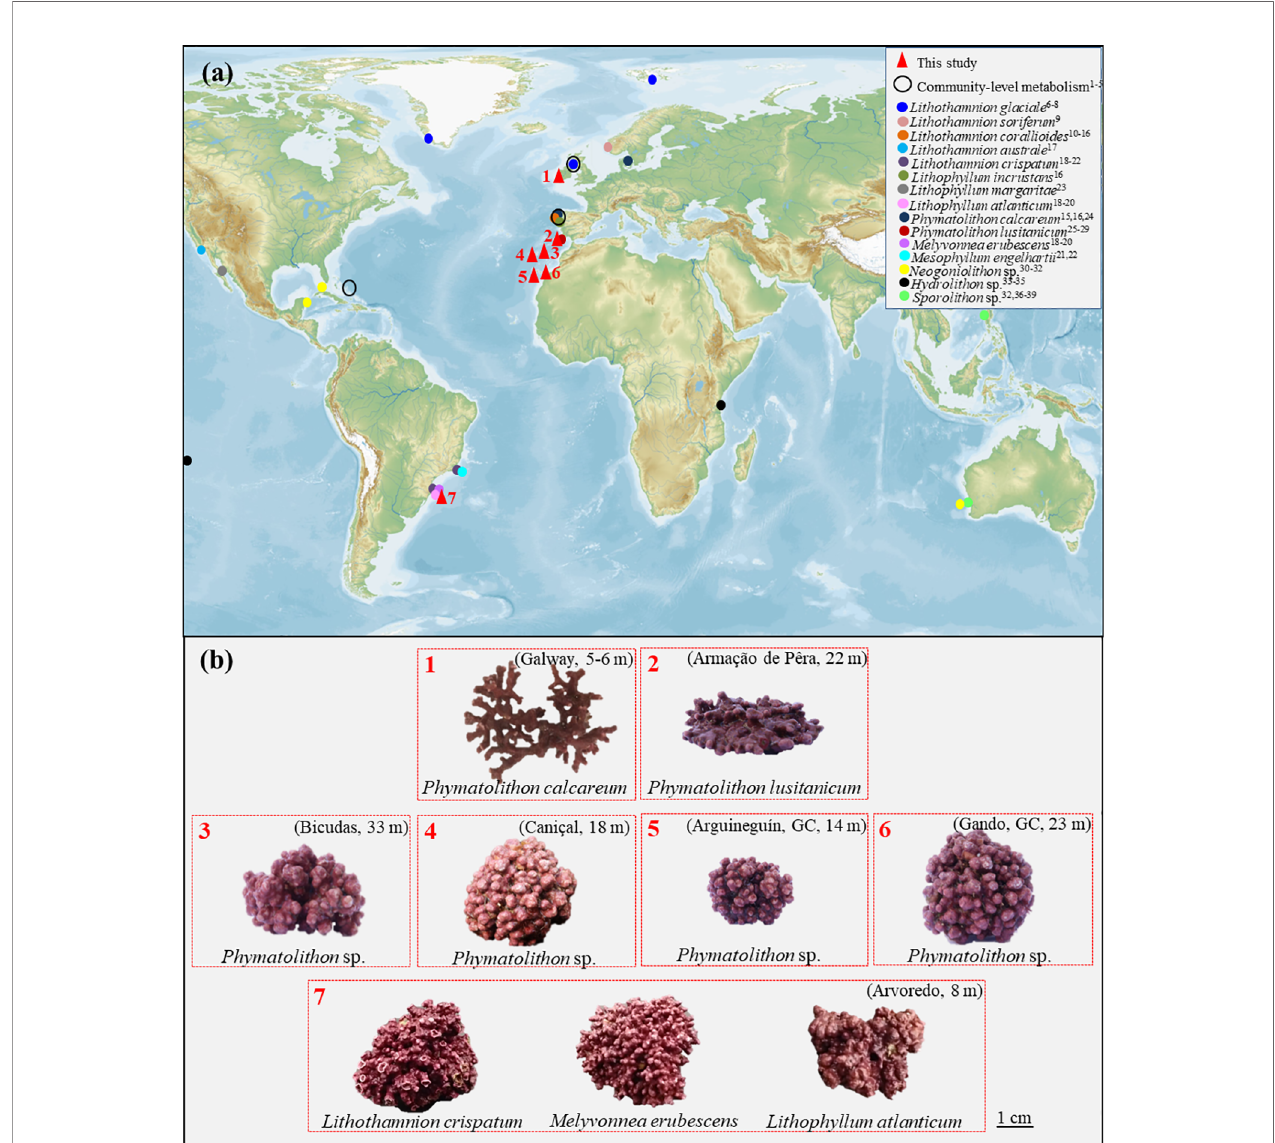
FIGURE 1 | (A) Overview of rhodolith species and locations for which primary production and/or calci fi cation rates have been reported. Sampling locations of rhodolith species studied in this work are indicated by red triangles (1- Galway, Ireland; 2- Armac ̧ ão de Pe ̂ ra, South Portugal; 3- Bicudas, Porto Santo Island, Portugal; 4- Canic ̧ al, Madeira Island, Portugal; 5- Arguinegu ı ́ n, Gran Canaria, Spain; 6- Gando, Gran Canaria, Spain; 7- Arvoredo, South Brazil). (B) Studied rhodolith species and their respective sampling location and depth (in parenthesis). Map was downloaded from Mapswire (https://mapswire.com/). ( 1 Martin et al., 2005; 2 Martin et al., 2007a; Martin et al., 2007b; 3 Attard et al., 2015; 4 Burdett et al., 2018; 5 Littler et al., 1991; 6 Büdenbender et al., 2011; 7 Kamenos et al., 2013; 8 Schoenrock et al., 2018; 9 Legrand et al., 2021; 10 Martin et al., 2006; 11 Noisette et al., 2013a; 12 Noisette et al., 2013b; 13 Legrand et al., 2017; 14 Legrand et